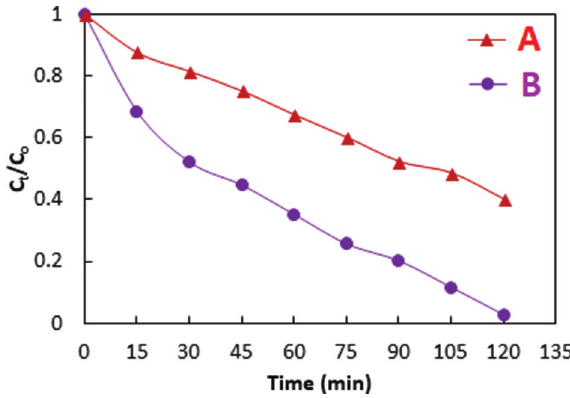
Figure 4a: Photo degradation of Methylene blue dye catalyzed by TiO (A) and Ag-TiO (B) in aqueous medium. 2 2